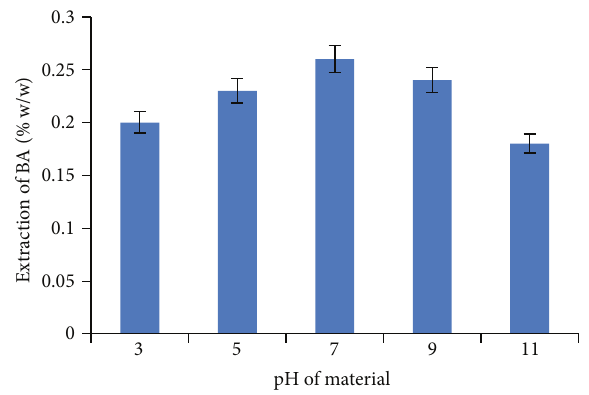
Figure 11: The effect of soxhlet extraction time on percentage extraction of BA.